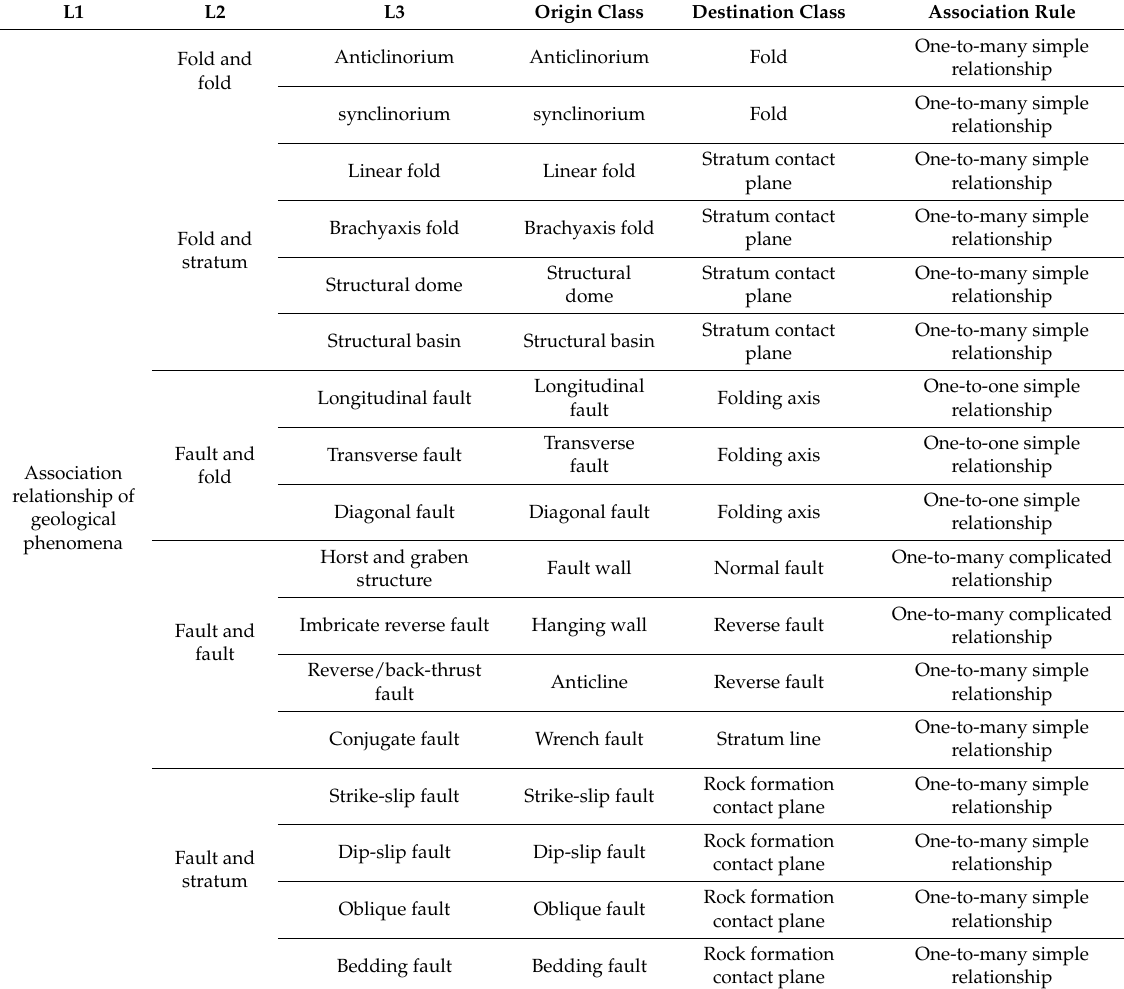
Table 5. Corresponding description of the association relationship in each combined relationship.